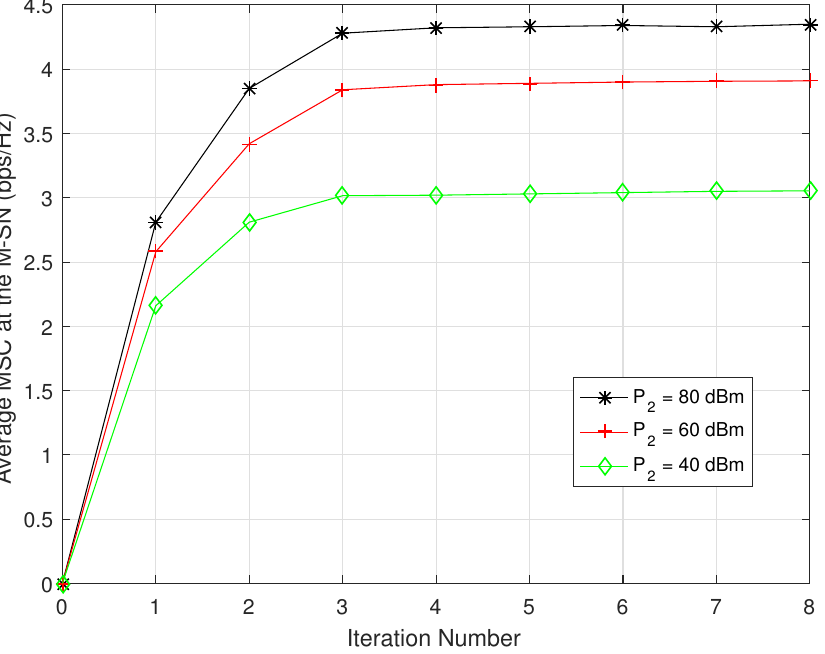
Figure 3. Average MSC at the M-SN with respect to iteration number.